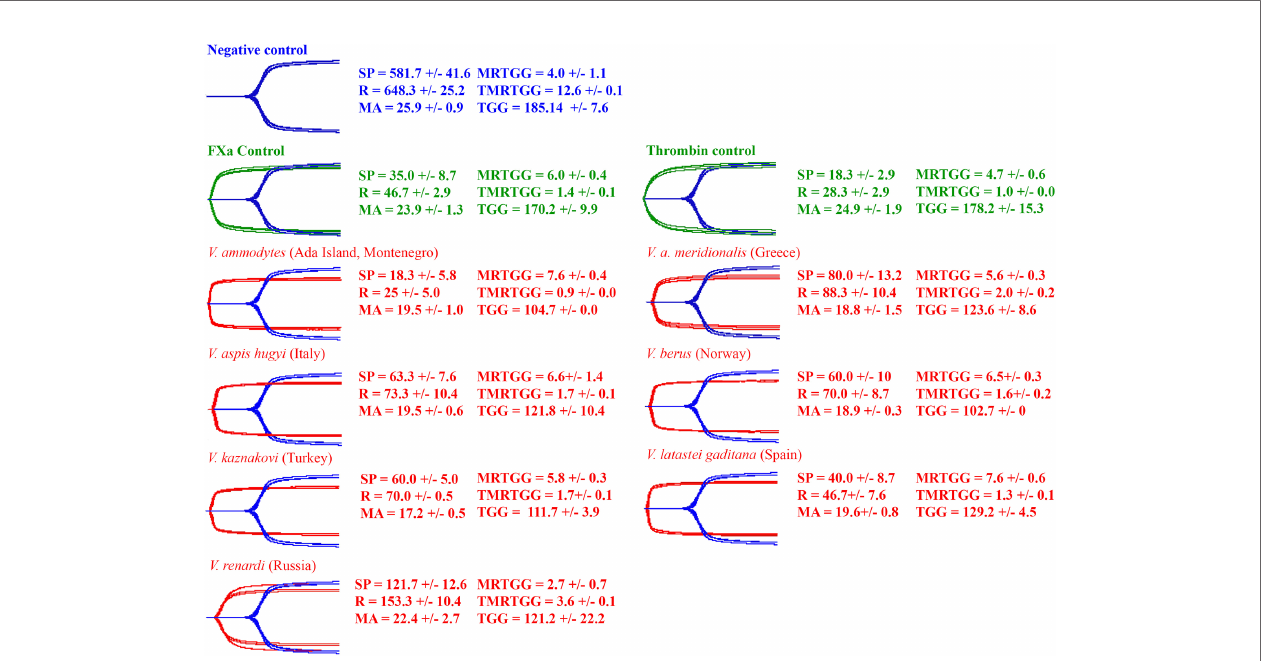
FIGURE 7 | Overlaid thromboelastography traces of spontaneous clotting negative control (blue), Factor X and thrombin positive controls (green) and venom- induced clotting experimental condition (red). Parameters: SP = the split point (time till clot formation begins) (sec); R = time until detectable clot (2 mm +) is formed (sec); MA = maximum amplitude of clot (mm); MRTG = maximum rate of thrombus generation (dynes/cm2/s); TMRTG = time to maximum rate of thrombus generation (min); and TGG = total thrombus generated (dynes/cm2). Values are mean ± SD of N = 3.